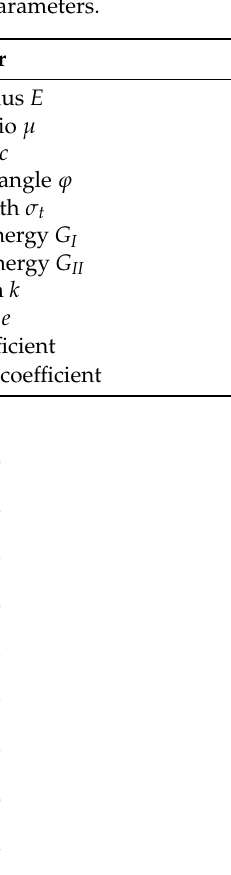
Figure 6. Model loading condition settings.